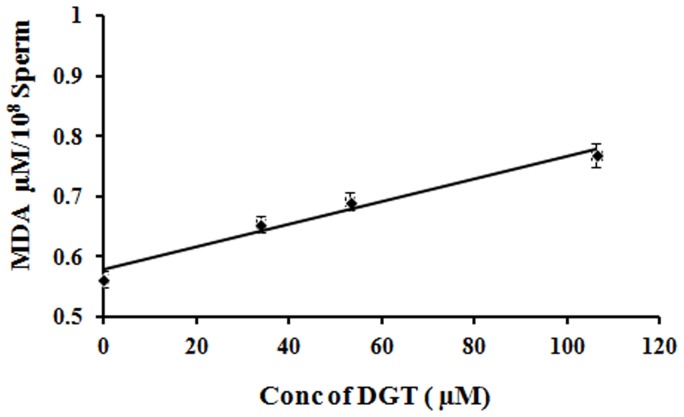
Effect of lipid peroxidation on human sperm.Generation of malondialdehyde (MDA) as a function of lipid peroxidation by human sperm treated with or without DGT at varying concentrations. Values on Y-axis represent mean ± SEM. values of five determinations (P<0.05). The graph shows dose-dependent increase in MDA generation following exposure of motile spermatozoa to DGT.